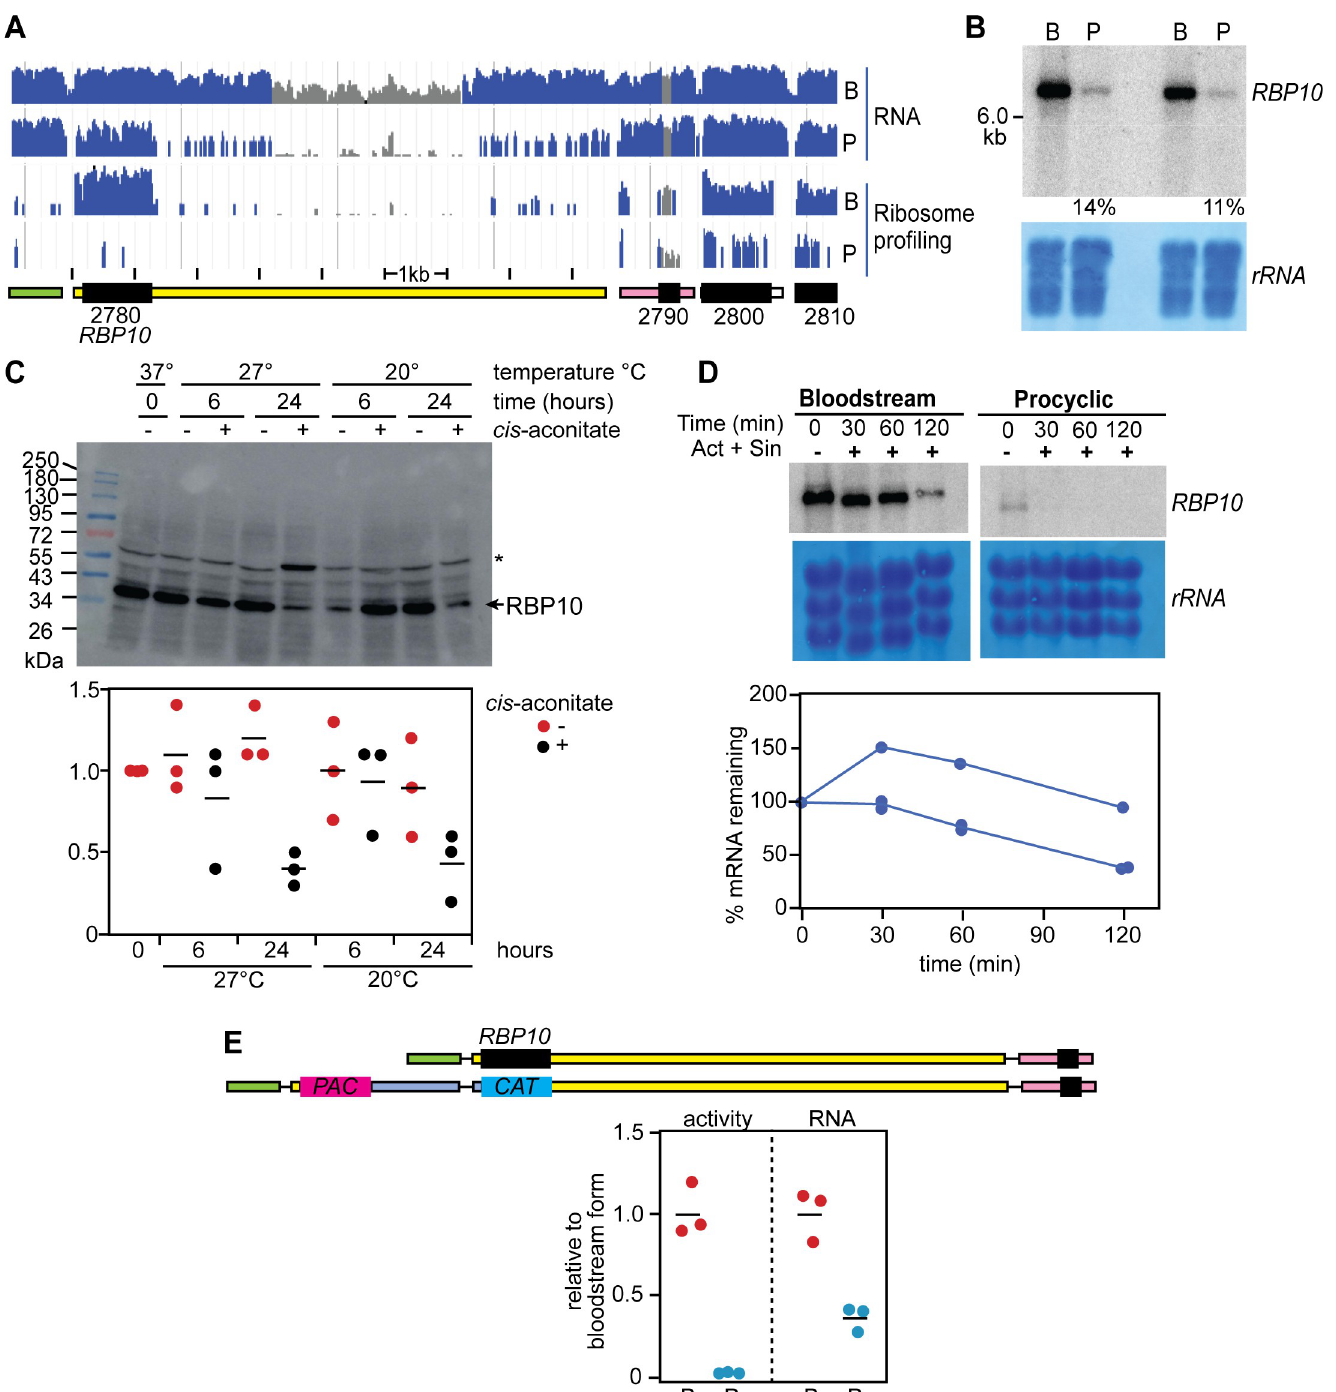
Fig 1. Developmental regulation of the RBP10 mRNA. A. RNA-sequencing data and ribosome profiling [14] reads for bloodstream forms (B) and procyclic forms (P), aligned to the relevant segment of the TREU927 reference genome. Unique reads are in blue and non-unique reads are in grey, on a log scale. The sequences in the RBP10 (Tb927.8.2780) 3’-UTR designated as non-unique in this image are also present in an TREU927 DNA contiguous sequence that has not been assigned to a specific chromosome; this segment is absent in the Lister427 (2018) genome. The positions of open reading frames (black) and untranslated regions have been re- drawn, with the initial "Tb927.8" removed for simplicity. Transcription is from left to right. Data from all remaining panels are for the EATRO1125 strain. B. Northern blot for two independent cultures showing the relative mRNA abundance of RBP10 mRNA in bloodstream forms (B) and in procyclic forms (P). A section of methylene blue staining is depicted to show the loading and the measured amounts in procyclic forms, relative to bloodstream forms, are also shown. C. Regulation of